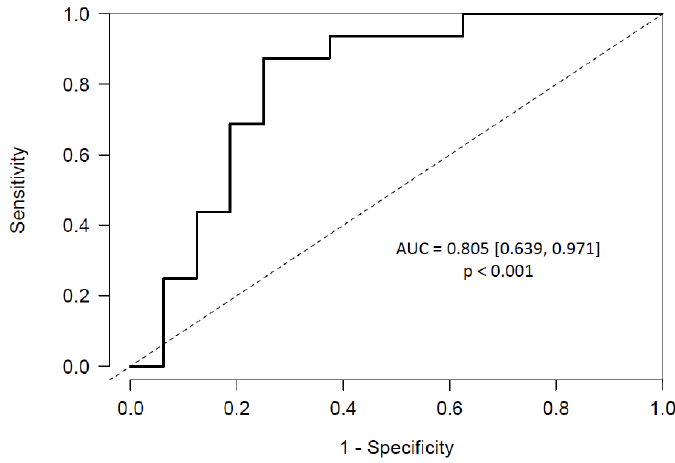
Figure 4. ROC curve of the multivariable elastic net predictive model for ccRCC that includes the expression of three miRNAs (miR-200a-3p, miR-34a-5p and miR-365a-3p) before surgery in urine.